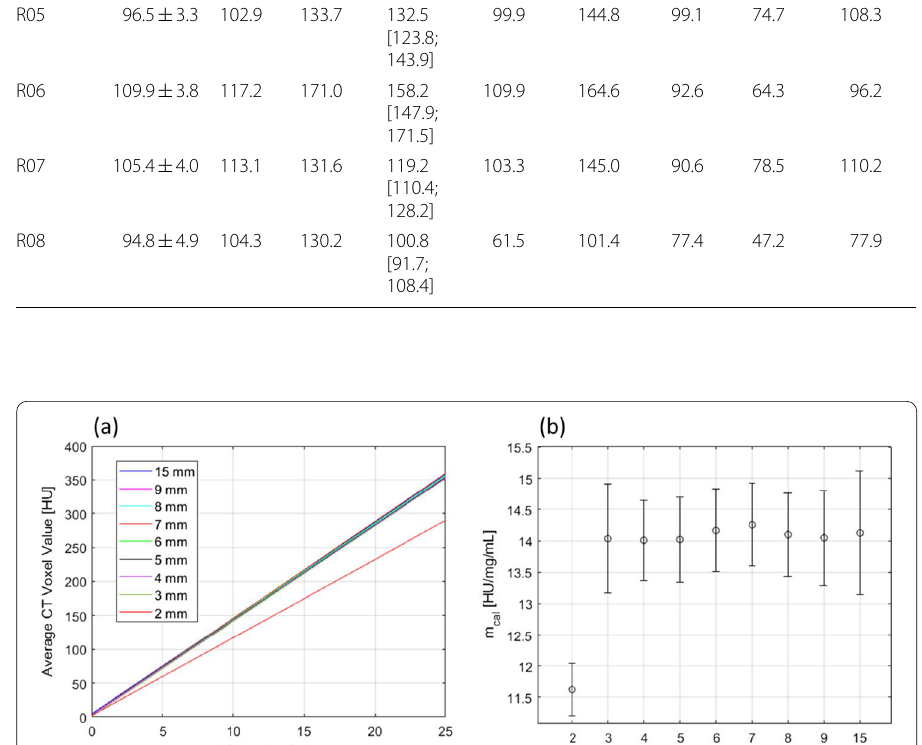
To justify the use of m cal for vessels with diameters 2 mm, additional contours ≤ were drawn around the 2 mm-diameter post containing 25.0 mg/mL to recover the nominal mass of Eye90 within the post. Figure 6a shows the recovered mass in the post as a function of an expanding radial shell thickness up to 2 mm, and Fig. 6b shows the placement of the shells relative to the true post boundary. The data indicate that, despite the use of m cal derived exclusively from the 15 mm-diameter posts, the nominal mass of Eye90 within the smallest post can still be recovered within 3%.